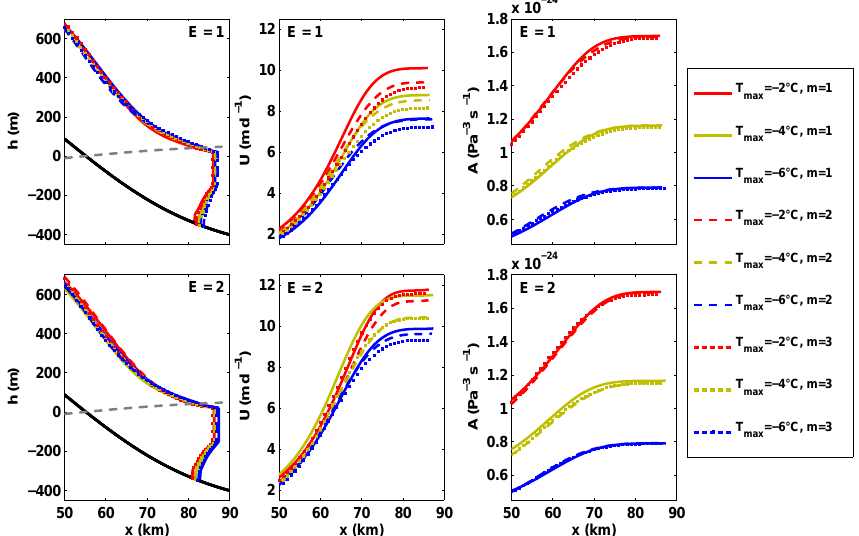
Fig. 3. Initial stable profiles of the (left panels) ice surface elevation, (center panels) speed, and (right panels) rate factor for the 18 model simulations performed using the seaward-dipping bed profile.